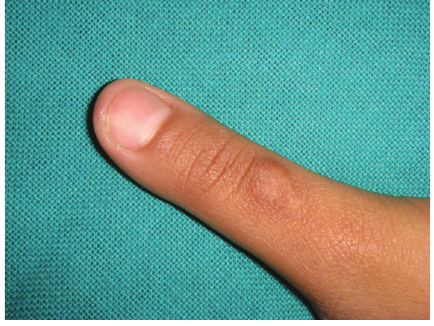
Figure 1: Callous formation was seen over digits of